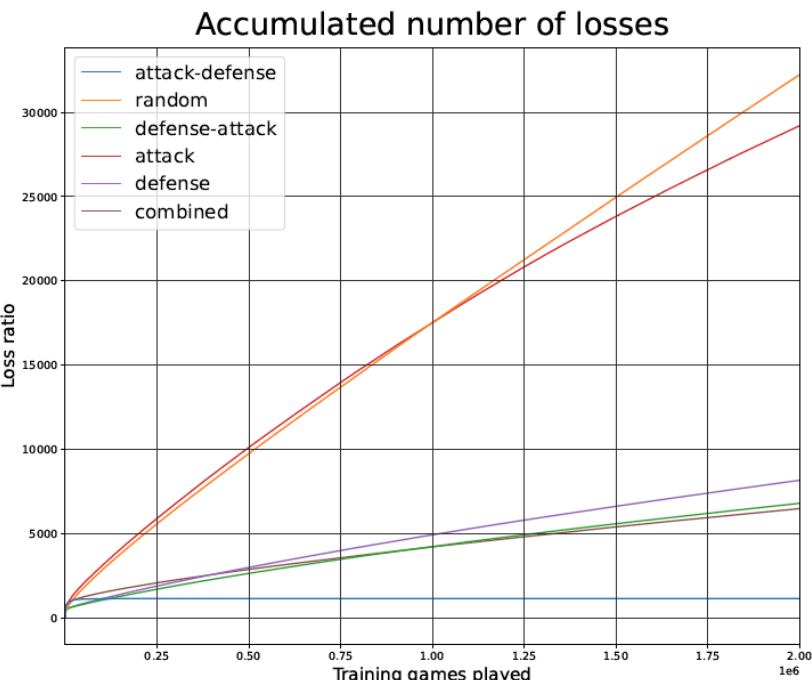
Figure 7. Games lost by the tic-tac-toe TD agent during the training phase as a function of the number of games played, for the different training strategies.